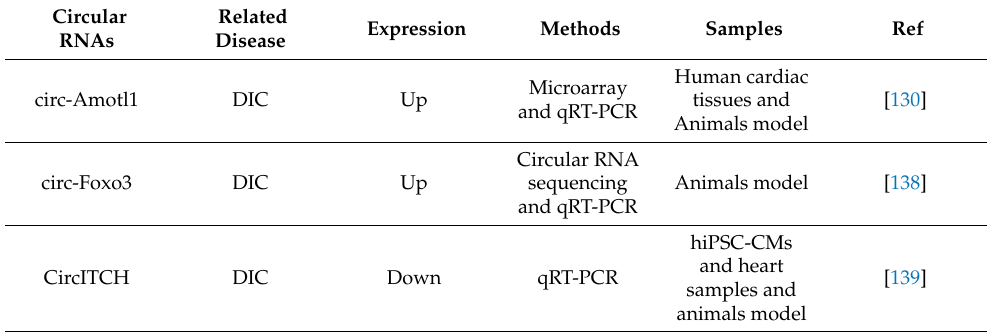
Table 4. The circular RNAs in doxorubicin-induced cardiomyopathy. Circular